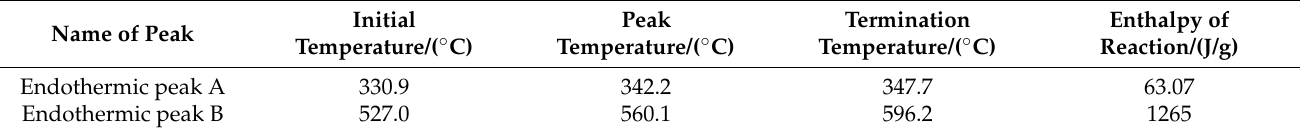
Figure 3. TG/DSC curve of PTFE. A and B: Endothermic peak. Table 5. Parameters of peak A and peak B.